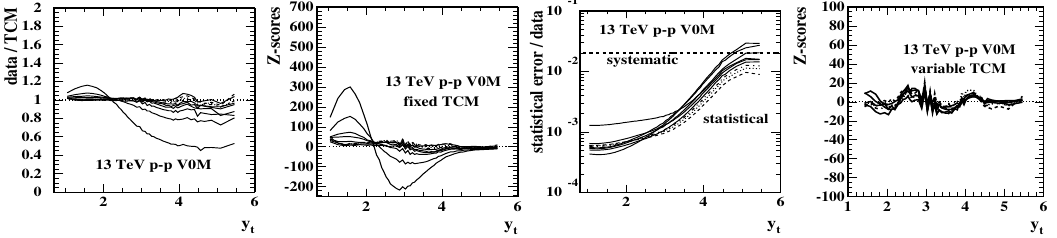
Figure 4: First: Data / model ratios for V0M selection. Second: Corresponding Z- scores. Third: Error / data ratios. Fourth: Z-scores for variable TCM in relation to V0M